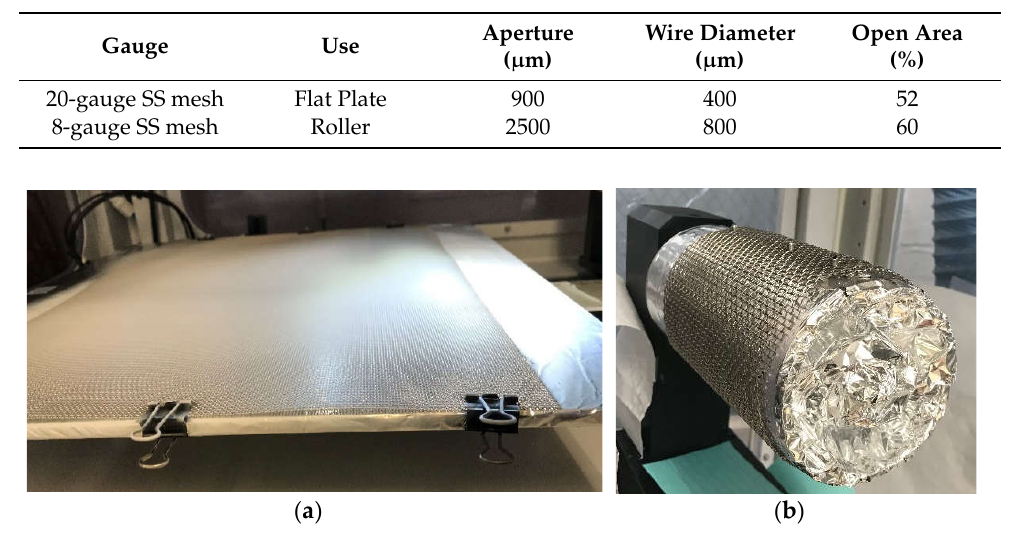
Table 1. Stainless steel wire mesh dimensions.